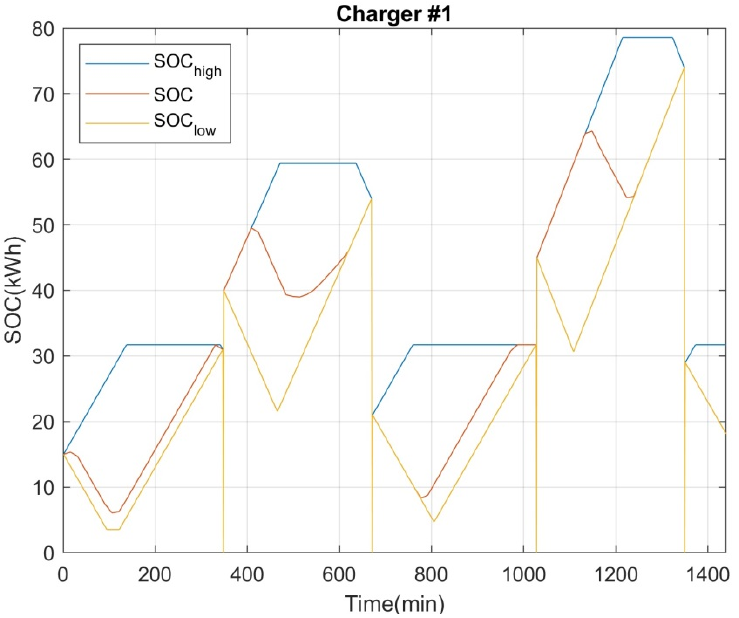
Figure 8. Optimal SOC trajectories of PEVs connected to a charger.